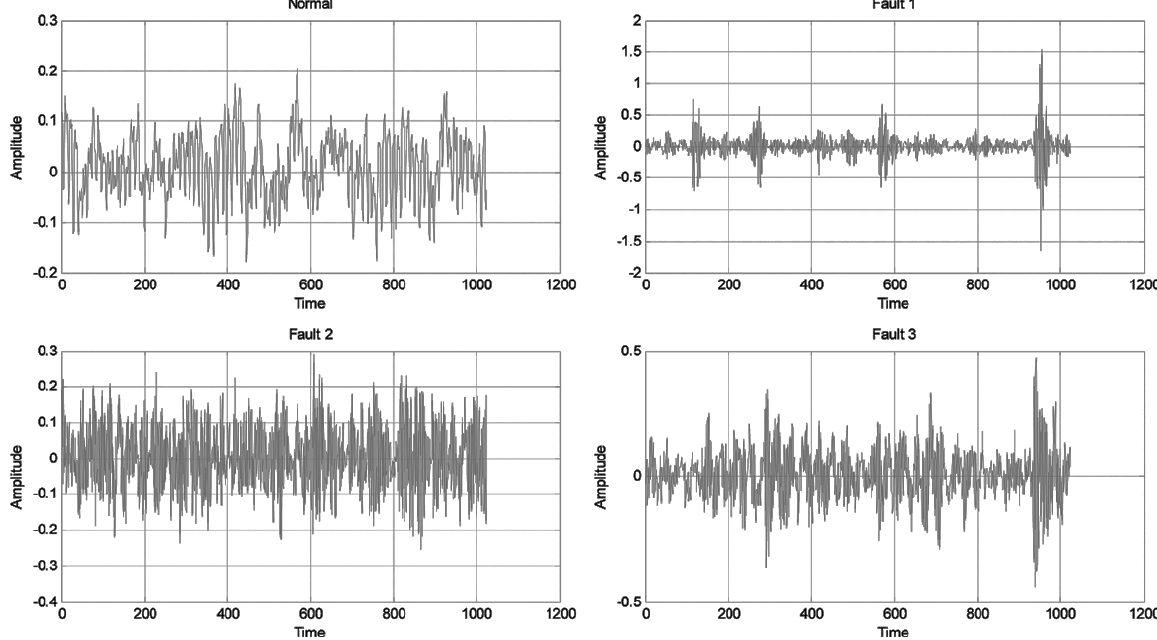
Fig. 5. Representative vibration signals under different bearing conditions in time